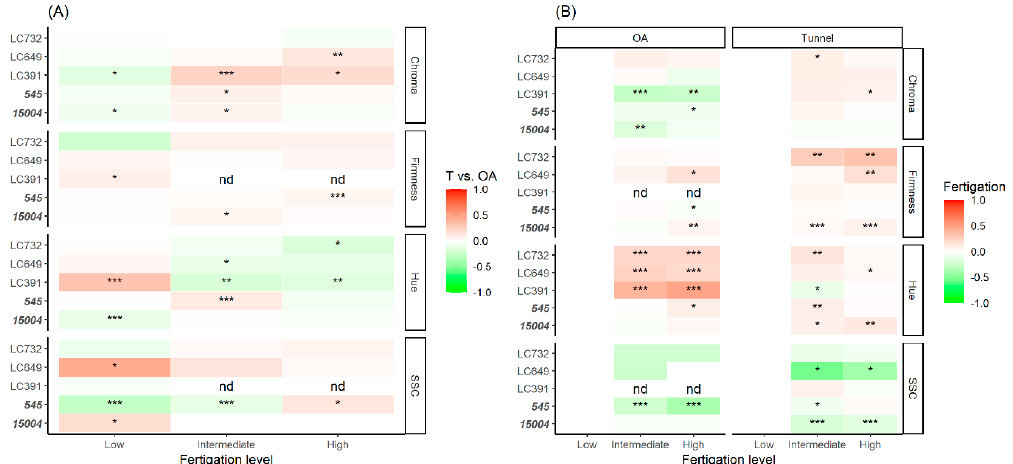
Figure 8. Environmental effects on quality traits in Penjar tomato landraces (LC732, LC649, LC391) and modern varieties (545, 15004, marked in bold). ( A ) Effect of cultivation under tunnel (T) in comparison with cultivation in open air (OA) conditions, across increasing fertigation regimes. Color scale in heatmap represent the log2-transformed ratio of trait value in T respect to OA. ( B ) Effect of intermediate (75% ETc) and high (120% ETc) fertigation in comparison with low fertigation regimes (25% ETc) under OA and T environments. Color scale in heatmap represent the log2-transformed ratio of trait value at each fertigation respect low fertigation regimes. SSC: soluble solids content. Level of significance: * p < 0.05; ** p < 0.01; *** p < 0.001; empty when not significant ( p > 0.05); nd = data not